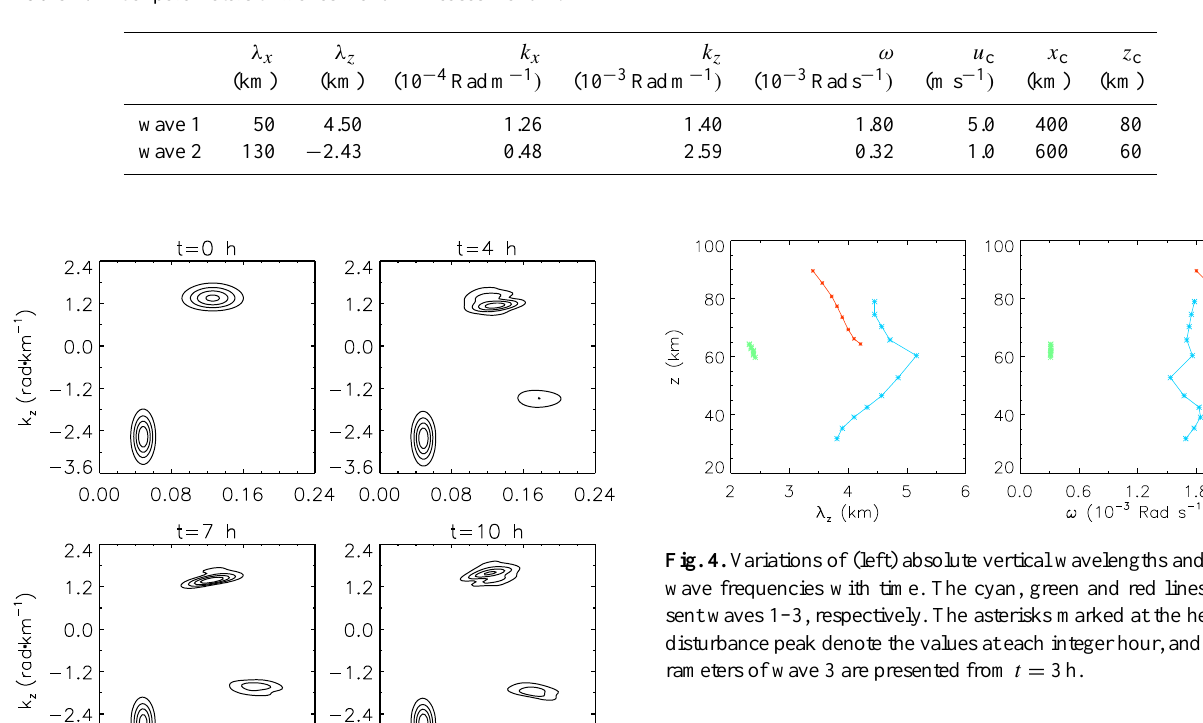
Table 1. Initial parameters of waves 1 and 2 in cases 1 and 2.